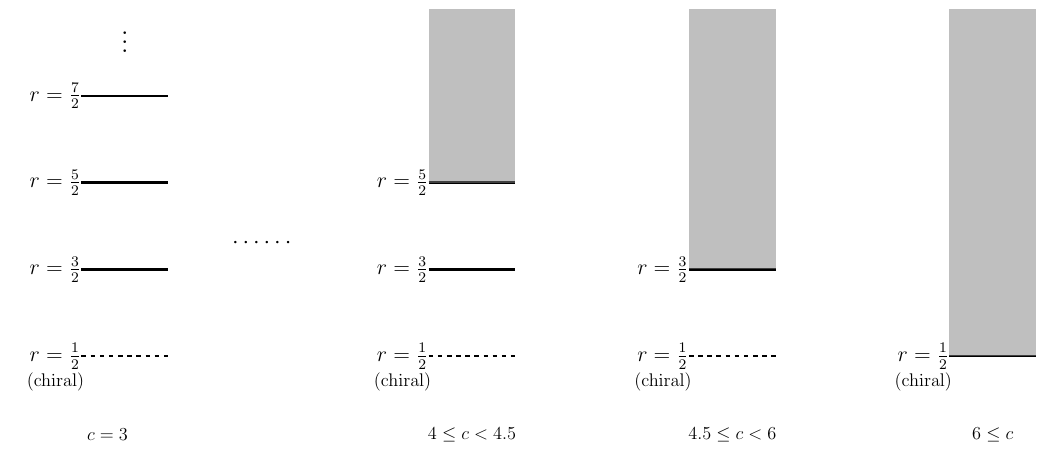
= 2 superconformal symmetry in the (cid:30) 1 (cid:30) 1 N degenerate primary is the chiral primary of 2 1 = 1. The internal chiral (cid:0) c < 6 because it violates the unitarity bound c= 3 2 q (cid:20) j j (cid:20)